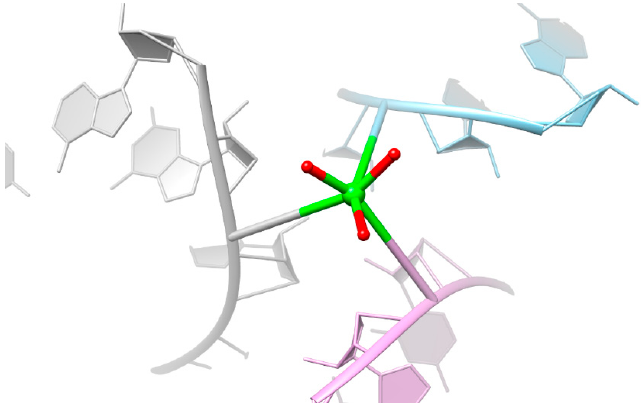
Figure 2. Positions of the metal ions found in different crystal structures of the octameric RNA duplex. The atoms of all RNA strand structures are superimposed, although the RNA duplex shown is the one solved in the presence of Ca 2+ , whereas the other structures are hidden.